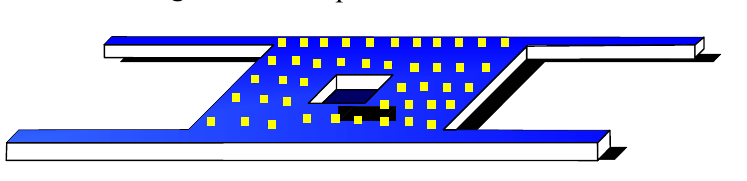
Figure 10. Flat plate sensor